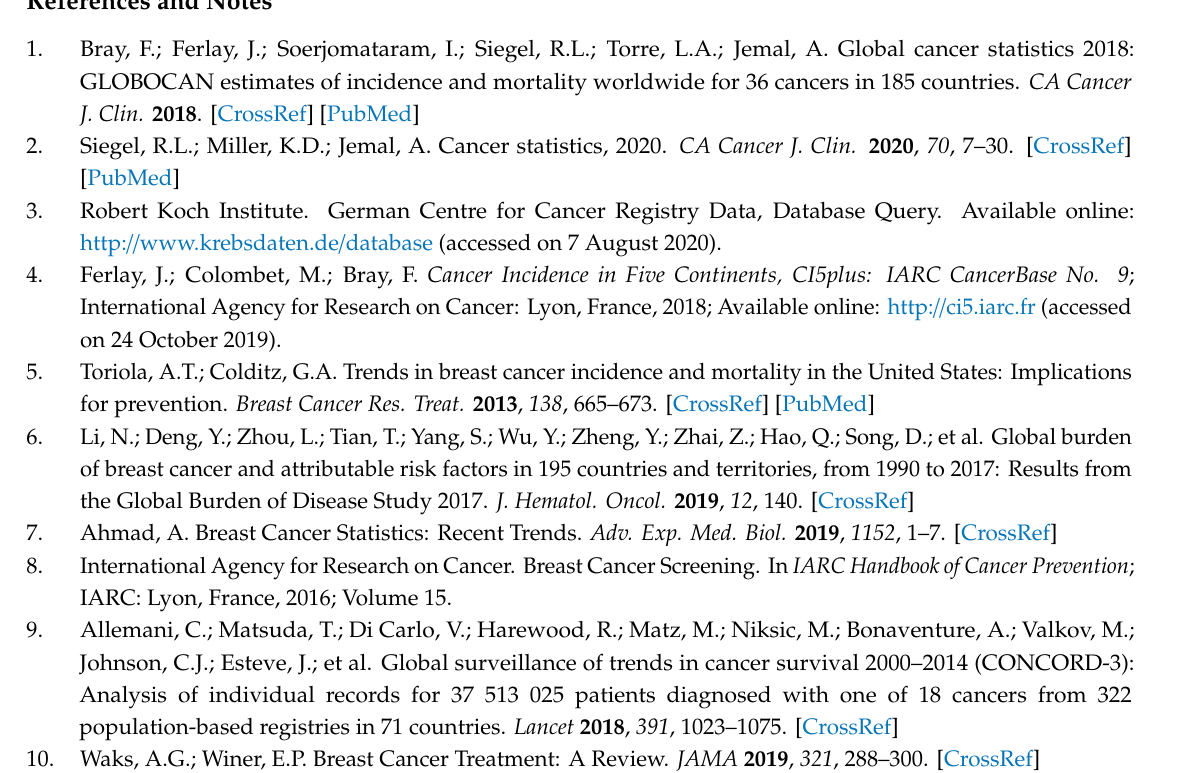
Table S1: Overview of included cancer registries; Table S2: Classification of morphology groups; Table S3: